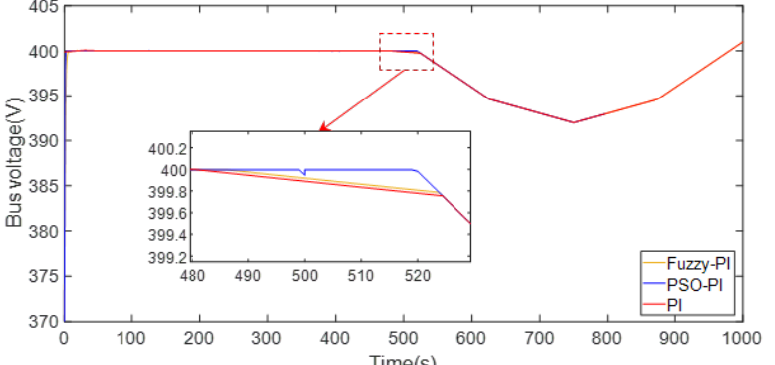
Figure 21. Bus voltage in Example 2 without AA-CAES.